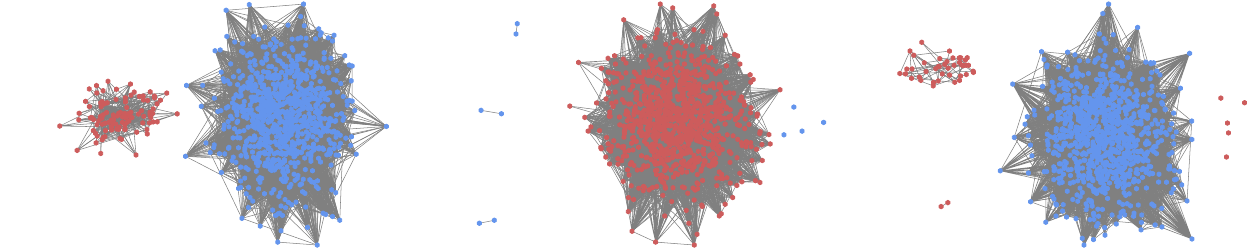
Figure 3. Examples of a final state for p = 0.2 (left), p = 0.7 (center) and p = 0.85 (right) using the UI